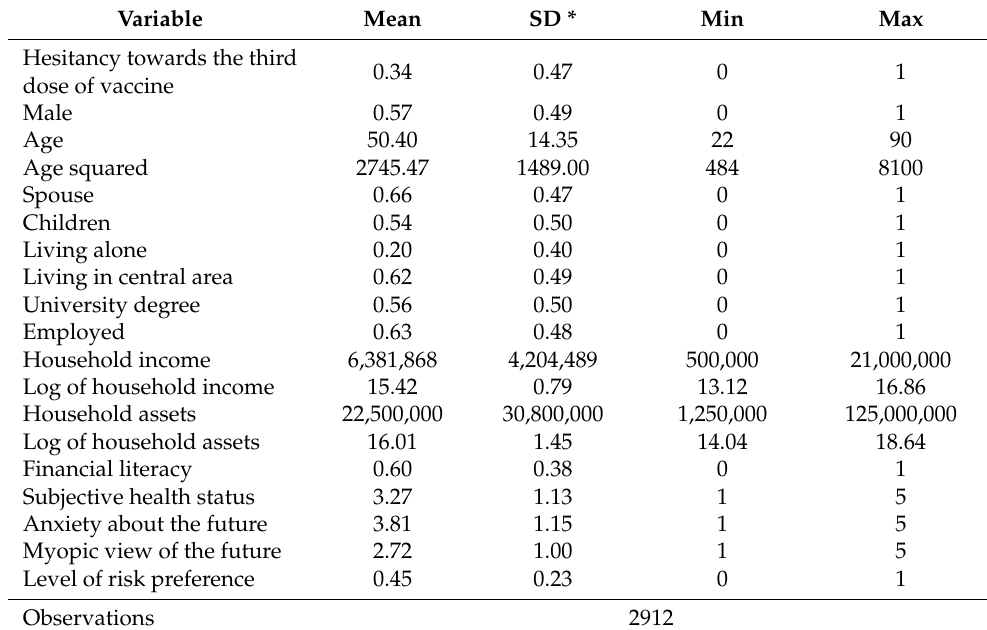
Table 2. Descriptive statistics.